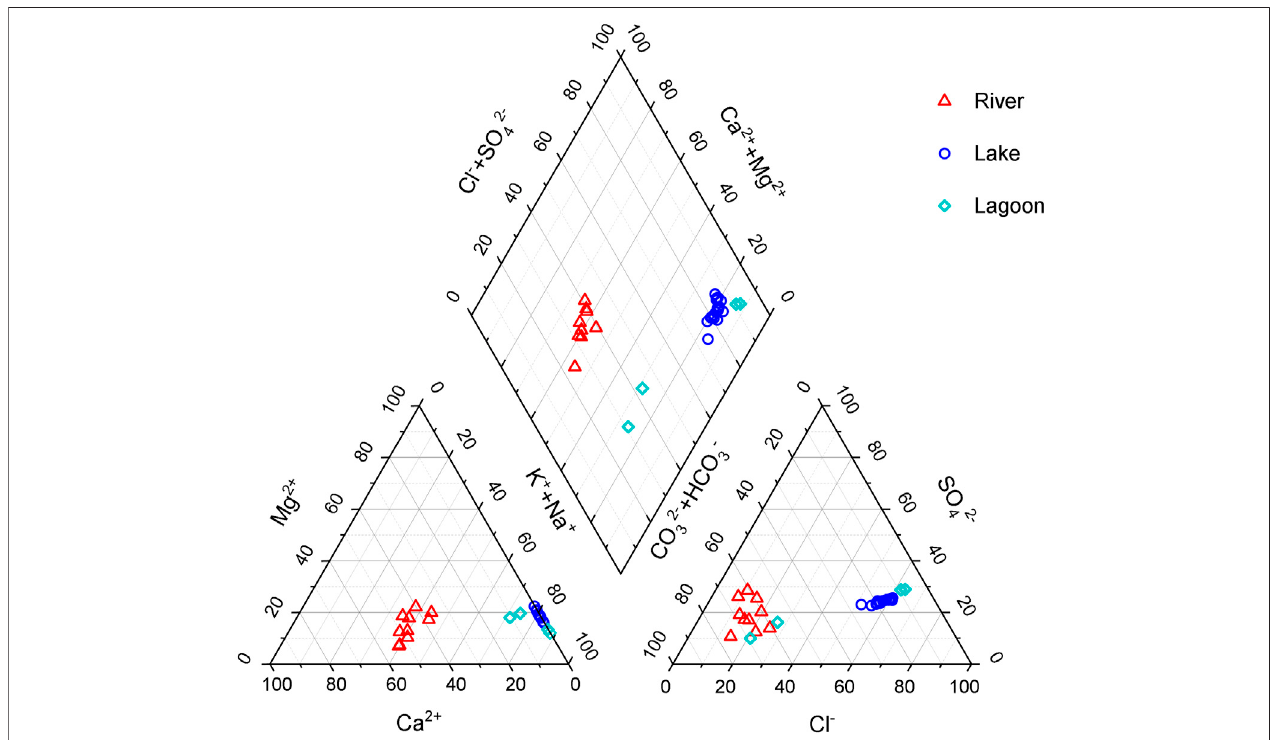
FIGURE 2 | Piper diagram plot for the study area (Piper,